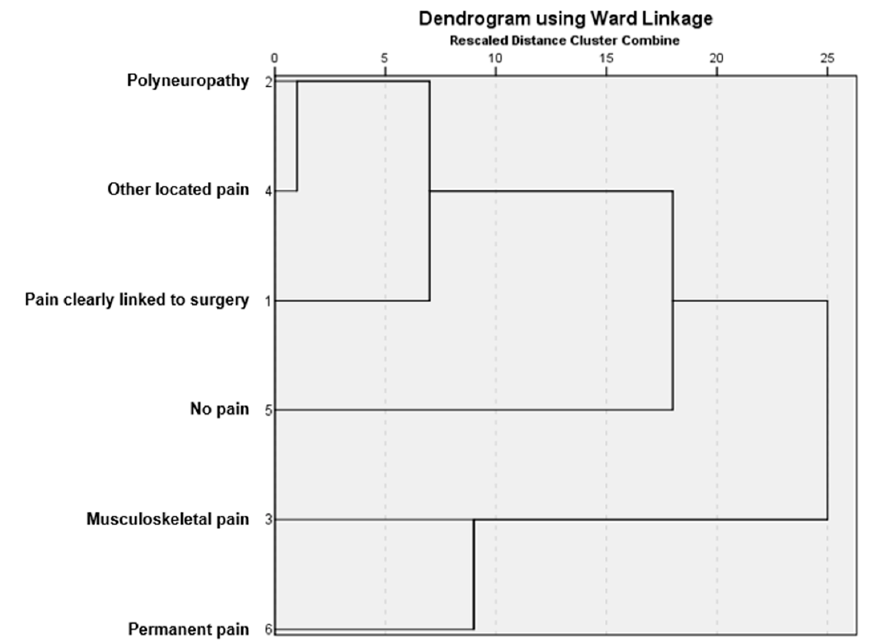
Figure A1. Dendrogram classifying the localisations of permanent pain one year after breast cancer surgery.